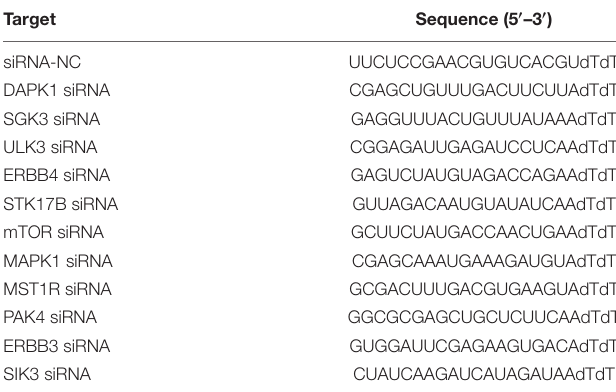
TABLE 2 | siRNA list. Target Sequence (5 (cid:48) –3 (cid:48)